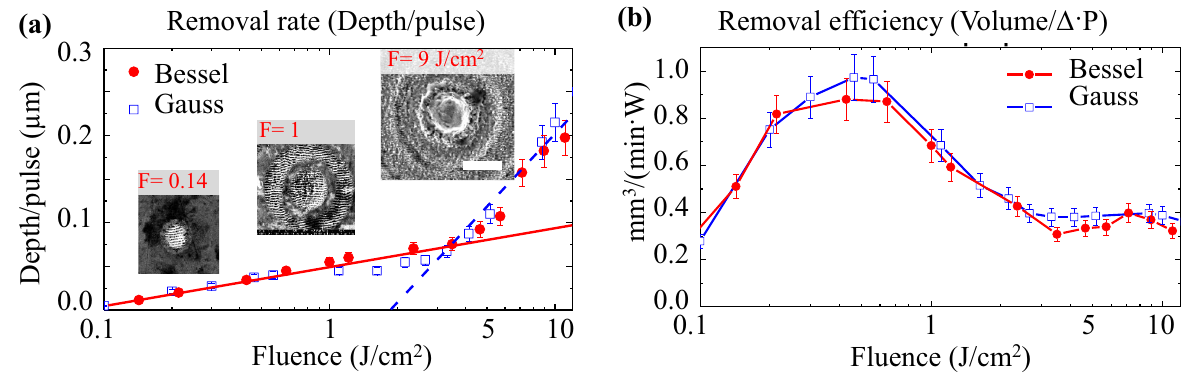
Figure 2. ( a ) Surface ablation for stainless steel, using ultrafast laser Bessel and Gaussian beams. The laser conditions were set identical at 1 kHz, 200 fs, and linear polarisation, while varying fluences. Removal rate curves show two different regimes: (i) Gentle regime (red solid-line) occurred at low pulse fluence ( < 2 J / cm 2 ), (ii) Strong regime (blue dash-line) occurred at high pulse fluence ( > 2 J/cm 2 ). Inset SEM images show topography of the craters ablated by the Bessel beam at different fluences (image scale: 10 μm). ( b ) Removal efficiency is evaluated by dividing the volume of the ablated crater produced in time unit by the power level. Both Bessel and Gaussian beams result in a similar efficiency trend with its peak within 0.5 window. In the both cases, the local power density expresses the density of the energy rate through the surface in the interaction region and not the total power of the